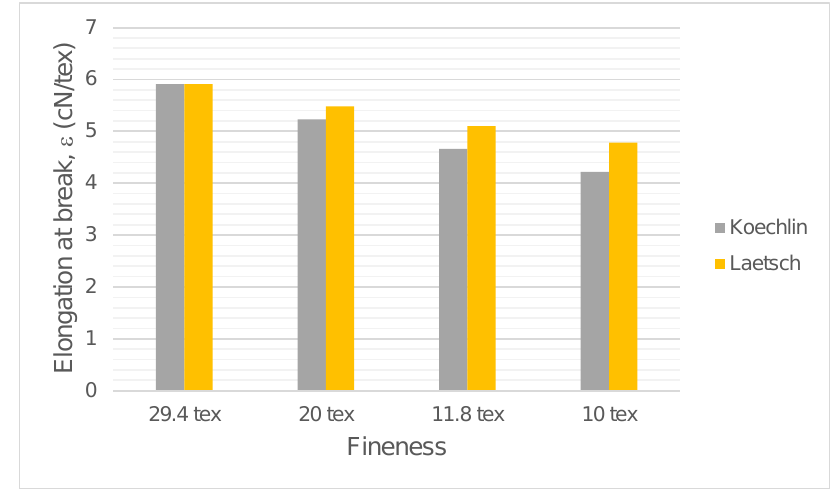
Figure 8. Elongation at break as a function of the number of turns per meter and yarn fineness.